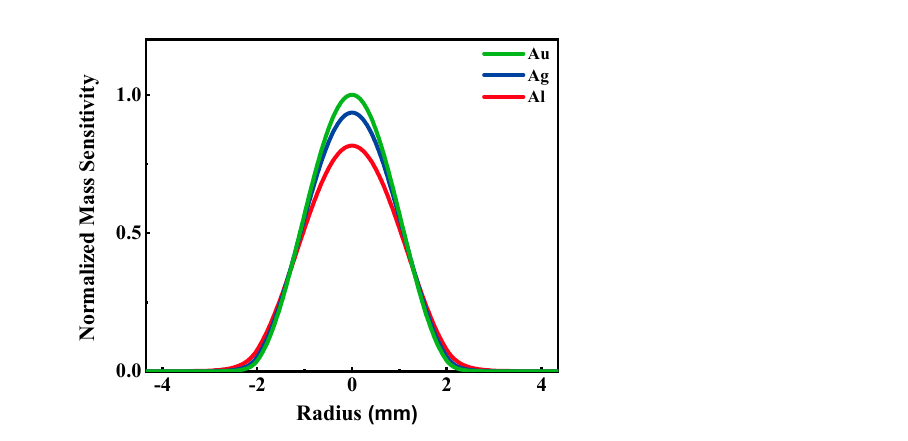
Figure 2. The normalized mass sensitivity distributions of QCMs with gold, silver, and aluminum electrodes.